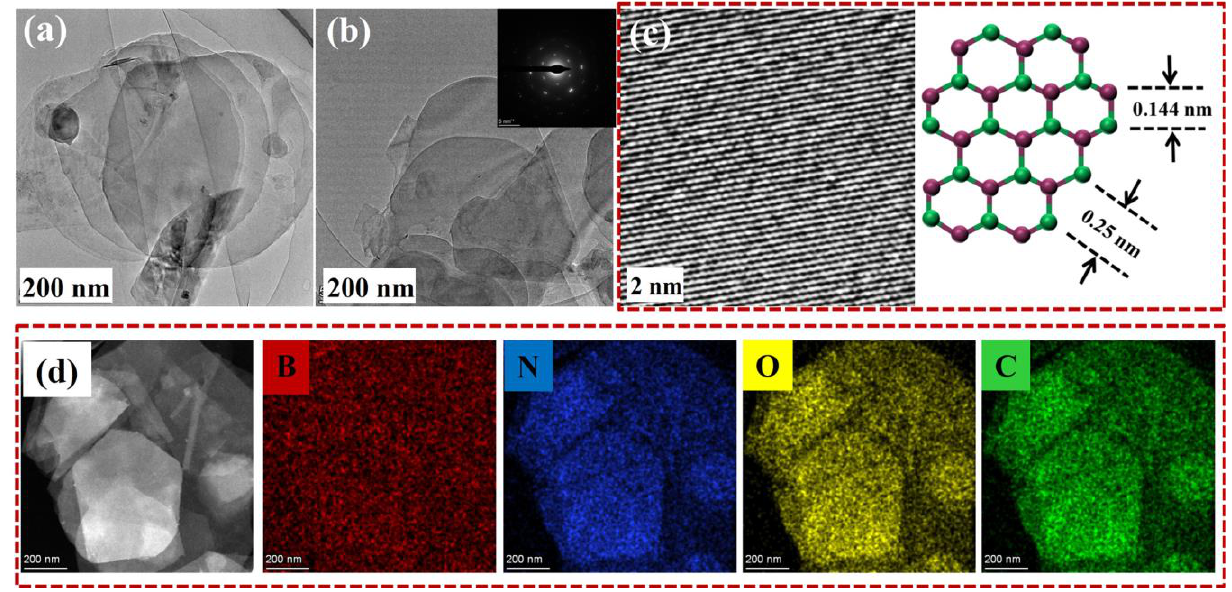
Figure 4. ( a , b ) TEM image of the Lys@BNNSs, with the inset of ( b ) showing the selected area electron diffraction pattern illustrating typical six-fold symmetry; ( c ) HRTEM image of Lys-BNNSs and a representative crystal structure of the basal plane of h-BN; ( d ) HR elemental mapping of Lys@BNNSs.